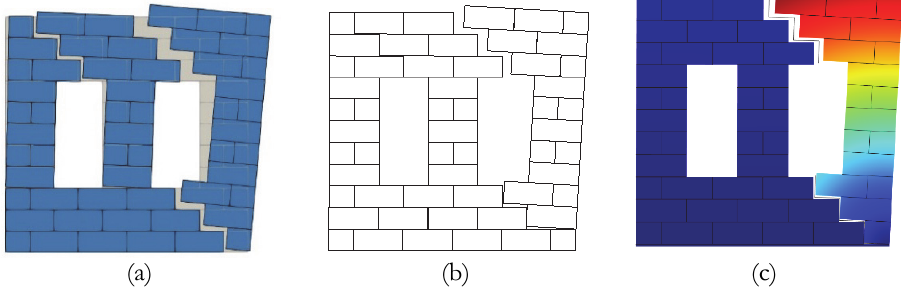
Figure 7: Collapse mechanism for Example 4, horizontal live load: ( a ) ALMA 2.0, ( 𝑏 ) FEM/DEM, ( 𝑐 )